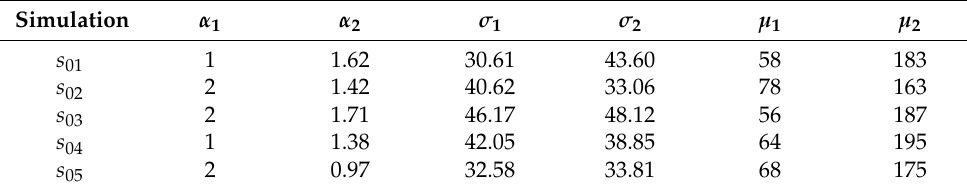
Table 1. Simulated histograms utilized as study cases for the preliminary experiment. Parameters α k , σ k , and µ k , ∀ k = { 1,2 } , correspond to the distribution model in (19). Simulation